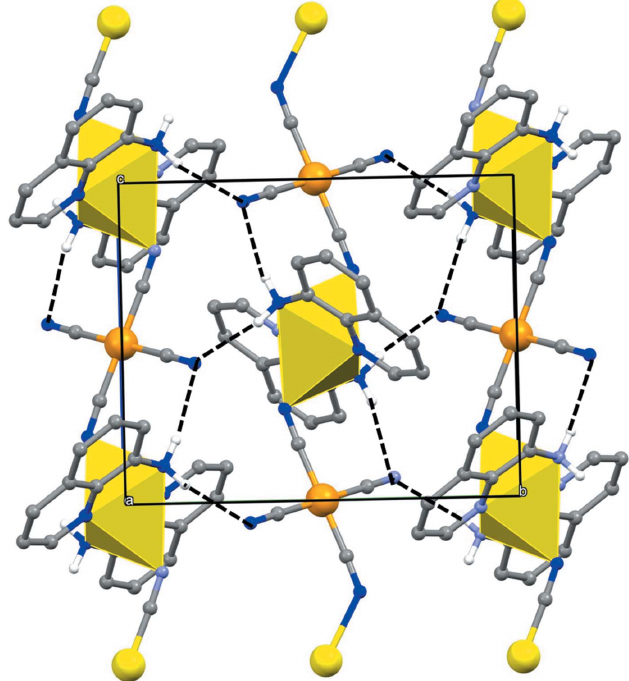
Figure 2 A projection along [100] of part of the crystal structure showing the formation of a hydrogen-bonded sheet of polymer chains, lying parallel to (100). For the sake of clarity, the H atoms bonded to C atoms have been